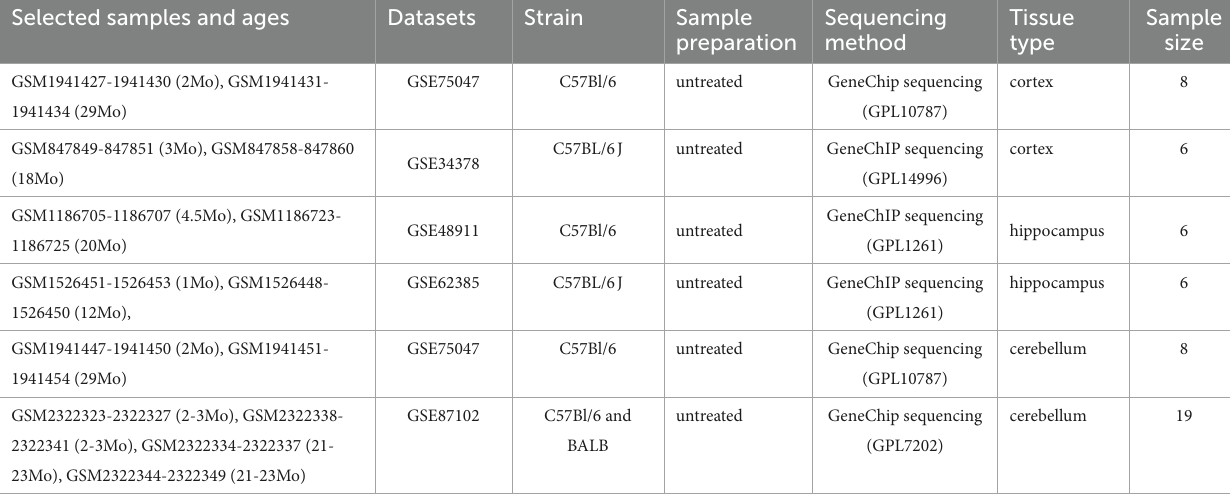
TABLE 1 Samples used in datasets. Selected samples and